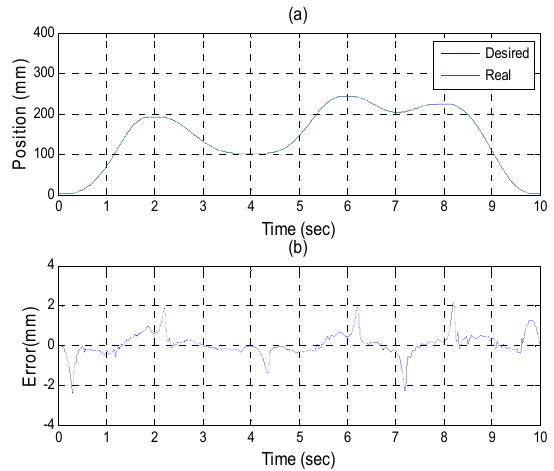
Figure 21. Experiments for A axis cylinder ( a ) tracking responses ( b ) tracking errors.